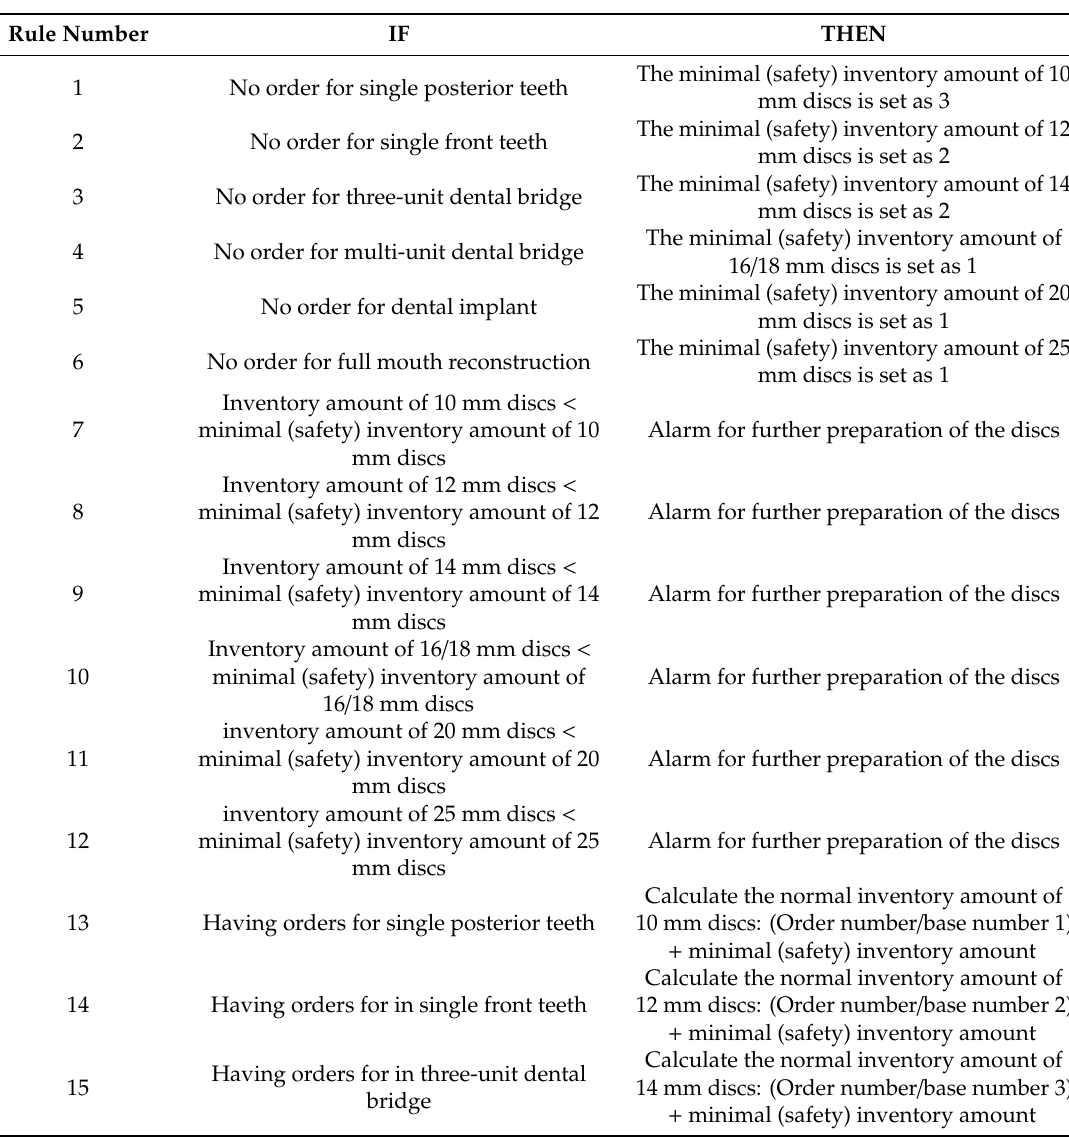
Table 3. The rules of the expert